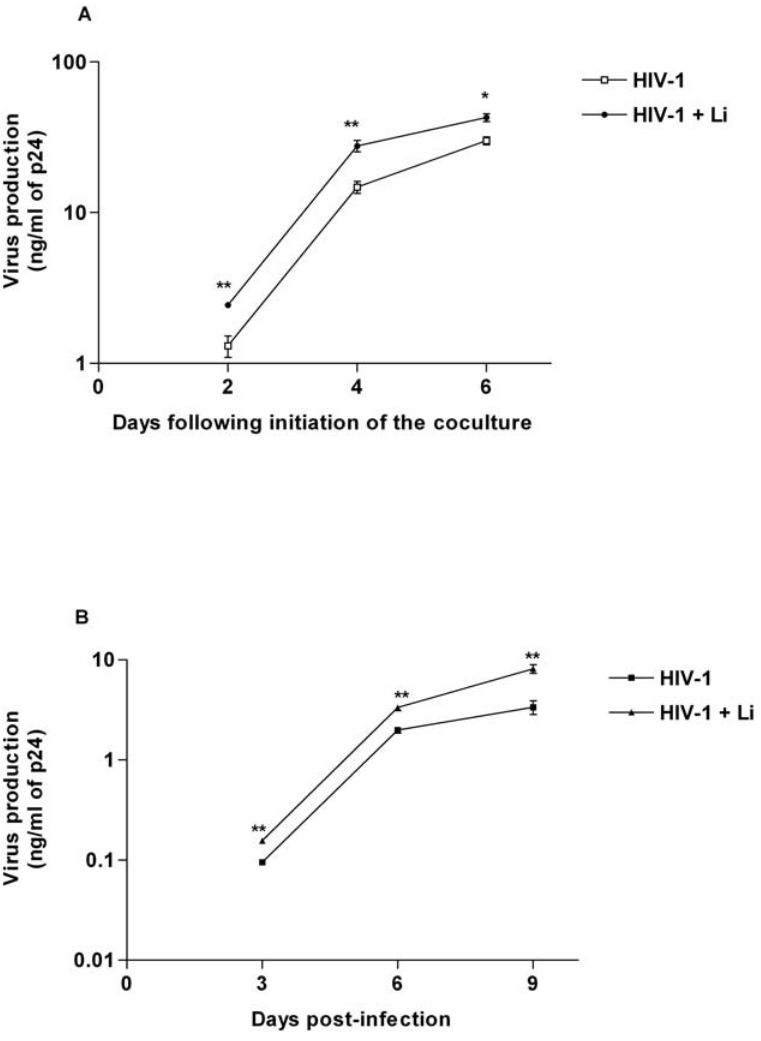
Figure 3. Leishmaniainfantum amastigotes enhance de novo virus production in DCs. (A) First, iDCs were pulsed for 60 min with NL4- 3Bal env and either left unexposed or exposed to Leishmania infantum amastigotes (Li). Next, cells were maintained in culture for 3 days before being cocultured with autologous CD4 + T cells. Virus production was estimated by measuring p24 levels in the culture supernatants at 4 days following initiation of the coculture. Data shown represent the means 6 SEM of triplicate samples and are representative of five independent experiments. Asterisks denote statistically significant differences from the cells infected with HIV-1 only (**, P , 0.01). (B) First, iDCs were pulsed for 60 min with NL4-3Bal env and either left unexposed or exposed to Leishmania infantum amastigotes (Li). Next, iDCs were maintained in culture in absence of autologous CD4 + T cells. Virus production was estimated by measuring p24 levels in the culture supernatants at the indicated time periods (i.e. 3, 6 and 9 days post-infection). Data shown represent the means 6 SEM of triplicate samples and are representative of five independent experiments. Asterisks denote statistically significant differences from the cells infected with HIV-1 only (**, P , 0.01).